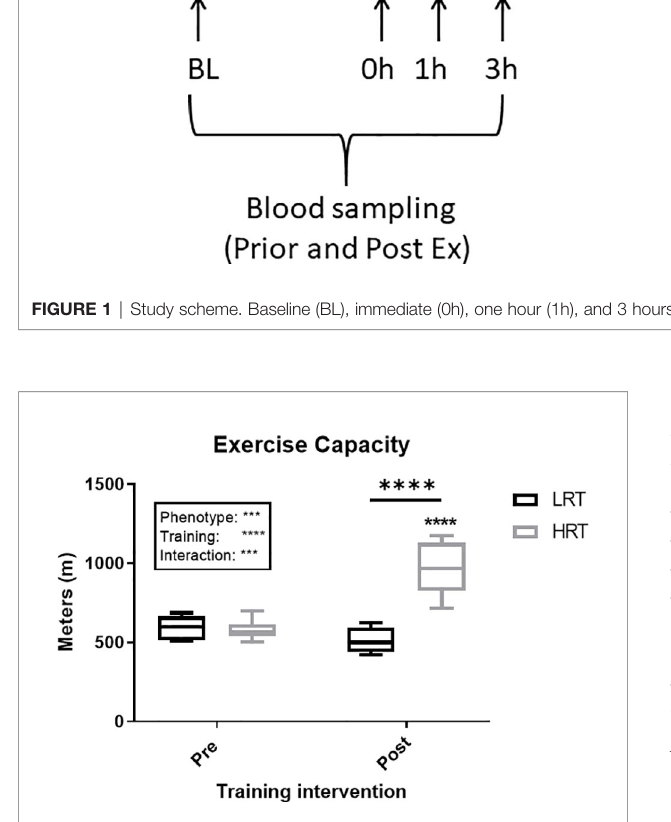
FIGURE 2 | Change in exercise capacity (meters) in low response trainers (LRT) and high response trainers (HRT). Values are means±SD. Analysis via two-way ANOVA with Sidak ’ s post hoc test. Main effects are shown in the text box. ***P<0.001, ****P<0.0001. Non-underlined symbols represent within group differences. Underlined symbols represent between